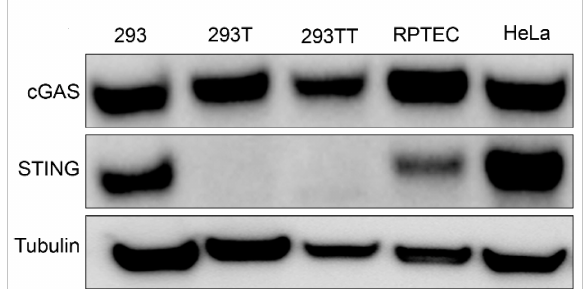
Figure 1. Western blot analysis of endogenous cyclic GMP–AMP synthase (cGAS) and stimulator of interferon genes (STING) expression in a panel of human cell lines. Tubulin was probed as a loading control. Western blot is representative of at least three independent